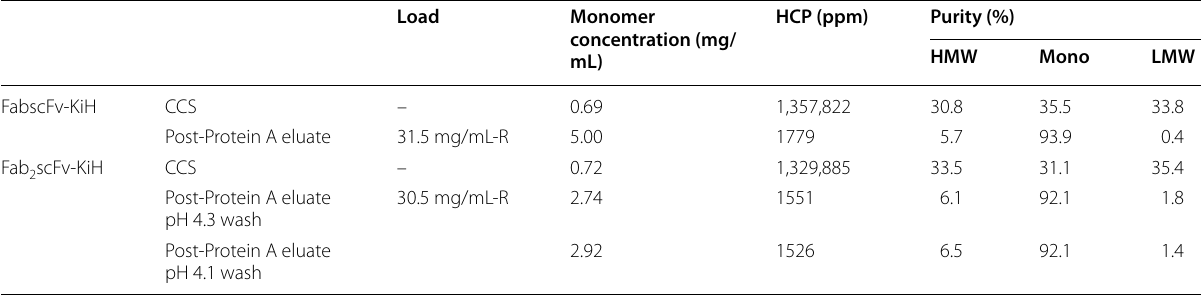
Table 1 Representative purity profile of cell culture supernatant (CCS) and post-Protein A eluates of FabscFv-KiH and Fab